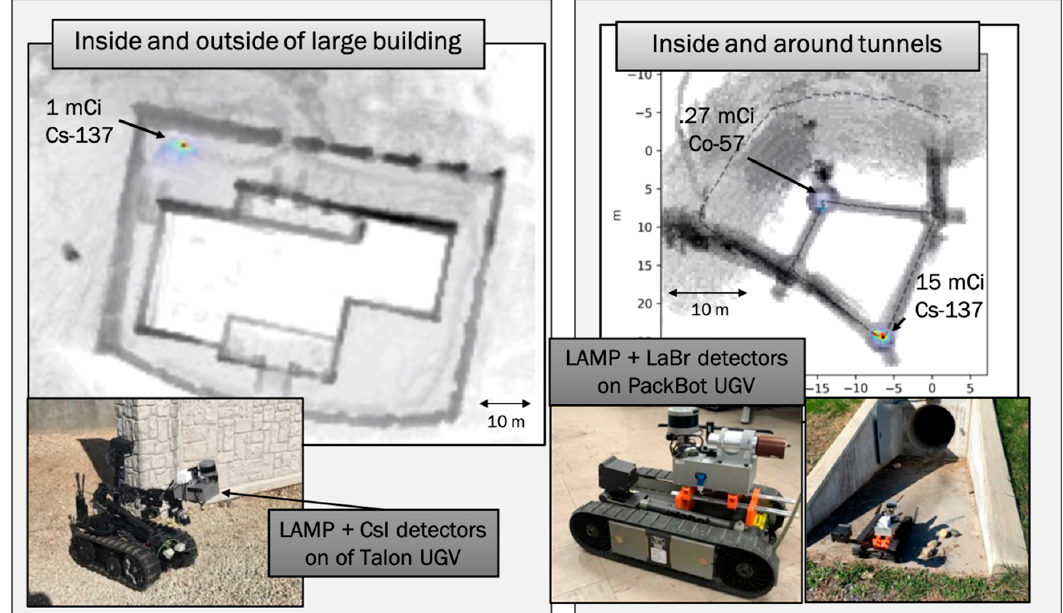
Figure 6. Demonstrations of 3-D SDF deployed on unmanned ground vehicles (UGVs). The localization and mapping platform (LAMP) system was combined with a 2 × 2 array of CsI detectors mounted on a Talon UGV ( left ) and a LaBr detector on a PackBot ( right ). In both cases, the non-imaging implementations of the radiation detectors were used to search for and localize sources within 3-D scenes, in or around buildings and structures ( left ) or inside tunnels ( right ).